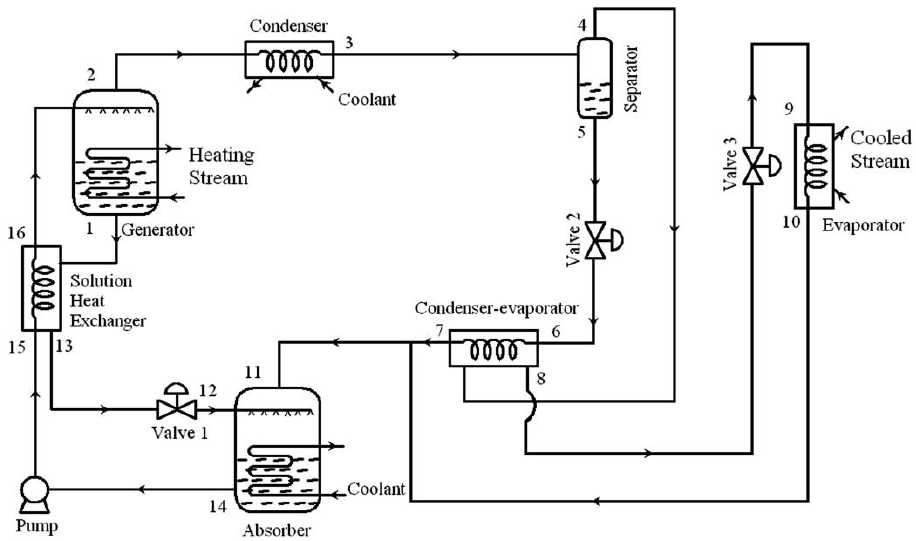
Figure 8. Schematic diagram of an auto-cascade absorption refrigeration system (ACARS) [87]. Reproduced with permission from [Elsevier], Elsevier, 2020.